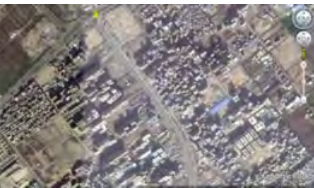
Figure 8. A high-density urban context around the 45 th Road (Google Earth,